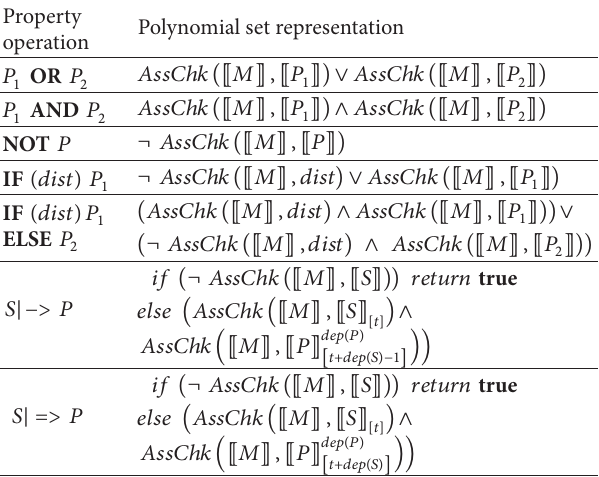
Table 3: Polynomial representation for property